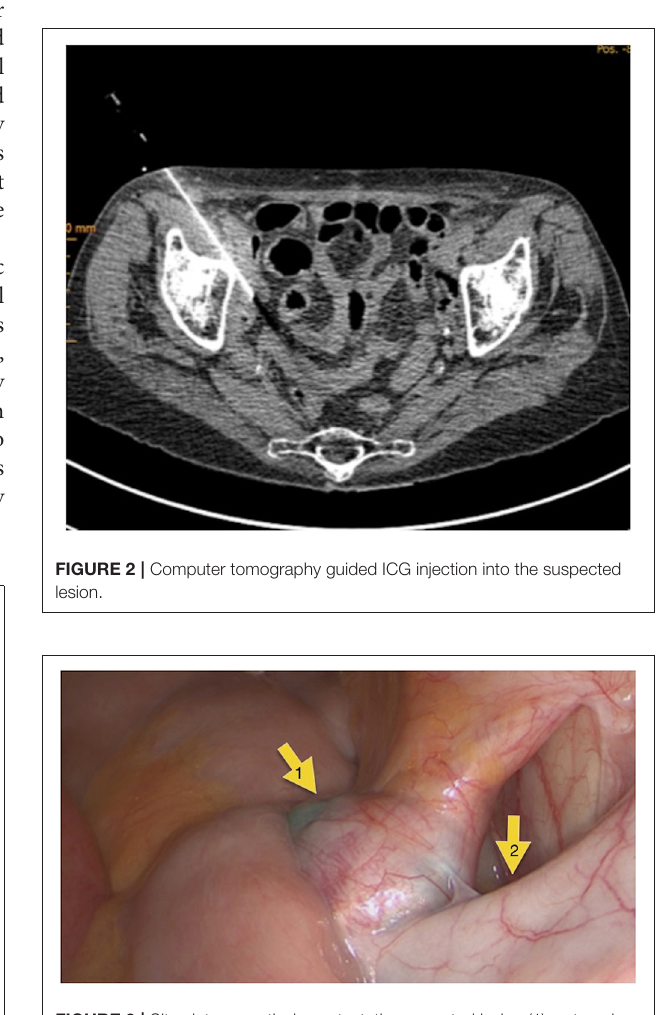
FIGURE 1 | Metastatic suspected lesions in CT scan (marked with arrow).